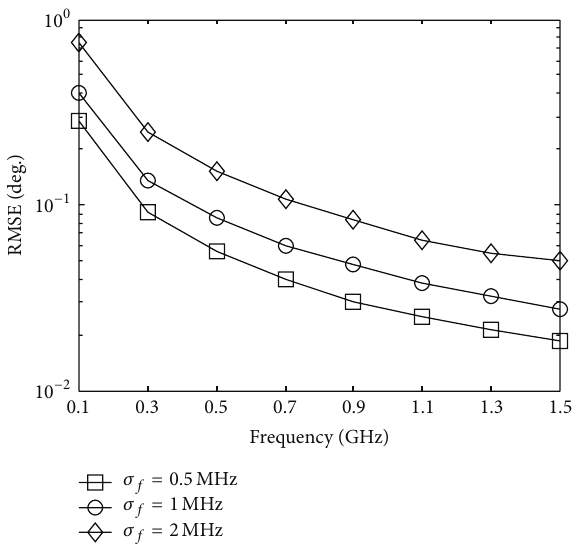
Figure 8: RMSE comparison, 𝑁 = 4 , 𝐾 = 5 , and SNR = 15 dB. the SNR and snapshots. The SNR varies from − 5 dB to 20 dB in 2.5 dB intervals. The RMSE of angle as a function of SNR with different snapshots is shown in Figure